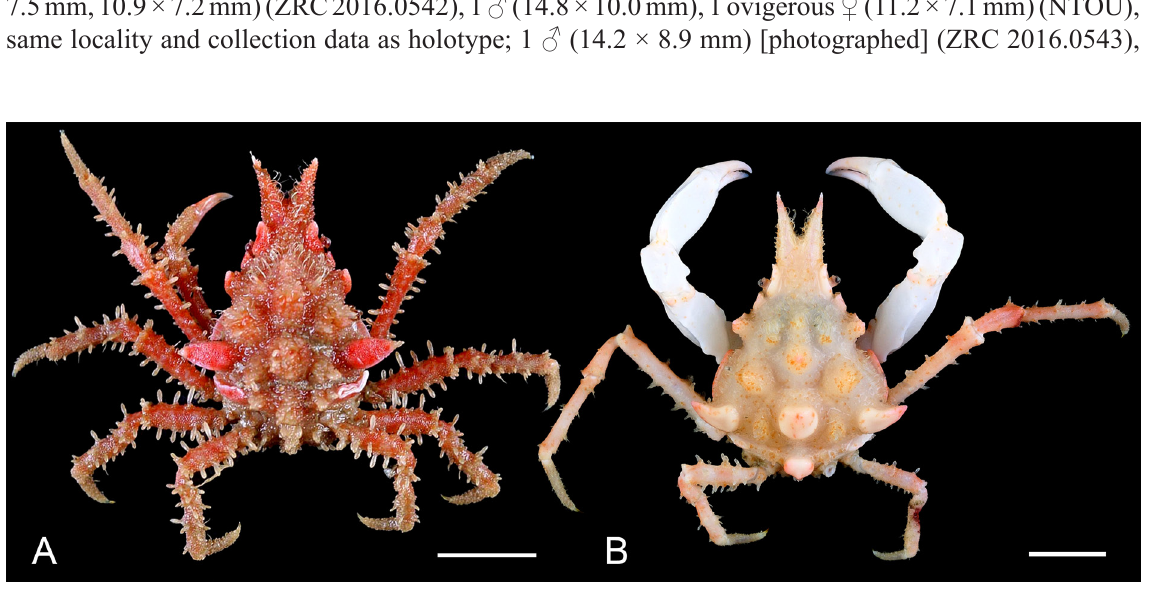
Fig. 4. Colour in life. A . Oxypleurodon bipartitum (Guinot & Richer de Forges, 1986), ovigerous ♀ (10.9 × 9.6 mm) (NMCR) (after Richer de Forges & Ng 2009b). B . Oxypleurodon leonis sp. nov., paratype, ♂ (15.1 × 9.6 mm) (ZRC 2016.0541), South China Sea. Scale bars = 5